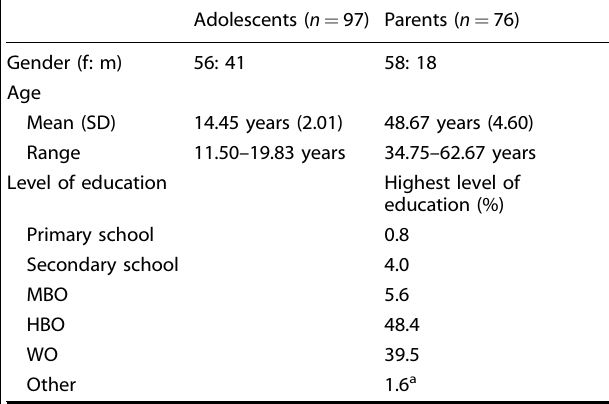
Table 4. Descriptive statistics of the adolescents and parents: age, gender and level of